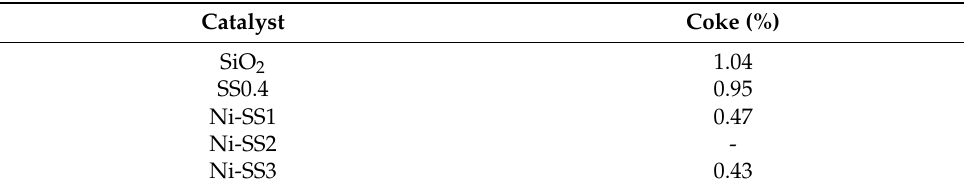
Figure 7. Percentage of the liquid product from the catalytic hydrocracking of waste frying oil at 450 °C with different catalysts. Table 4. Catalyst selectivity test from the catalytic hydrocracking of waste frying oil. Table 3. Percentage of coke formed using different